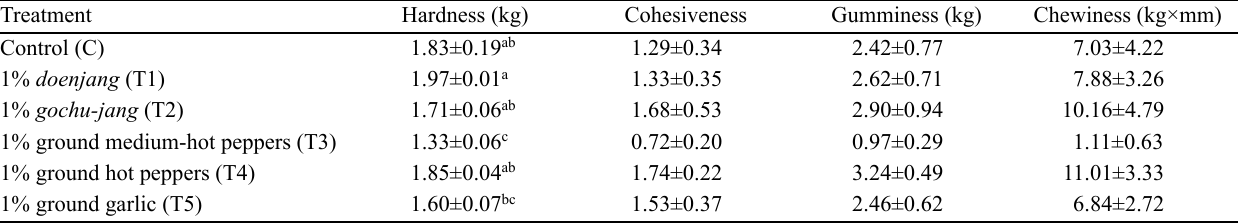
Table 4. Texture profiles of fermented sausages as affected by adding traditional seasonings 1 Treatment